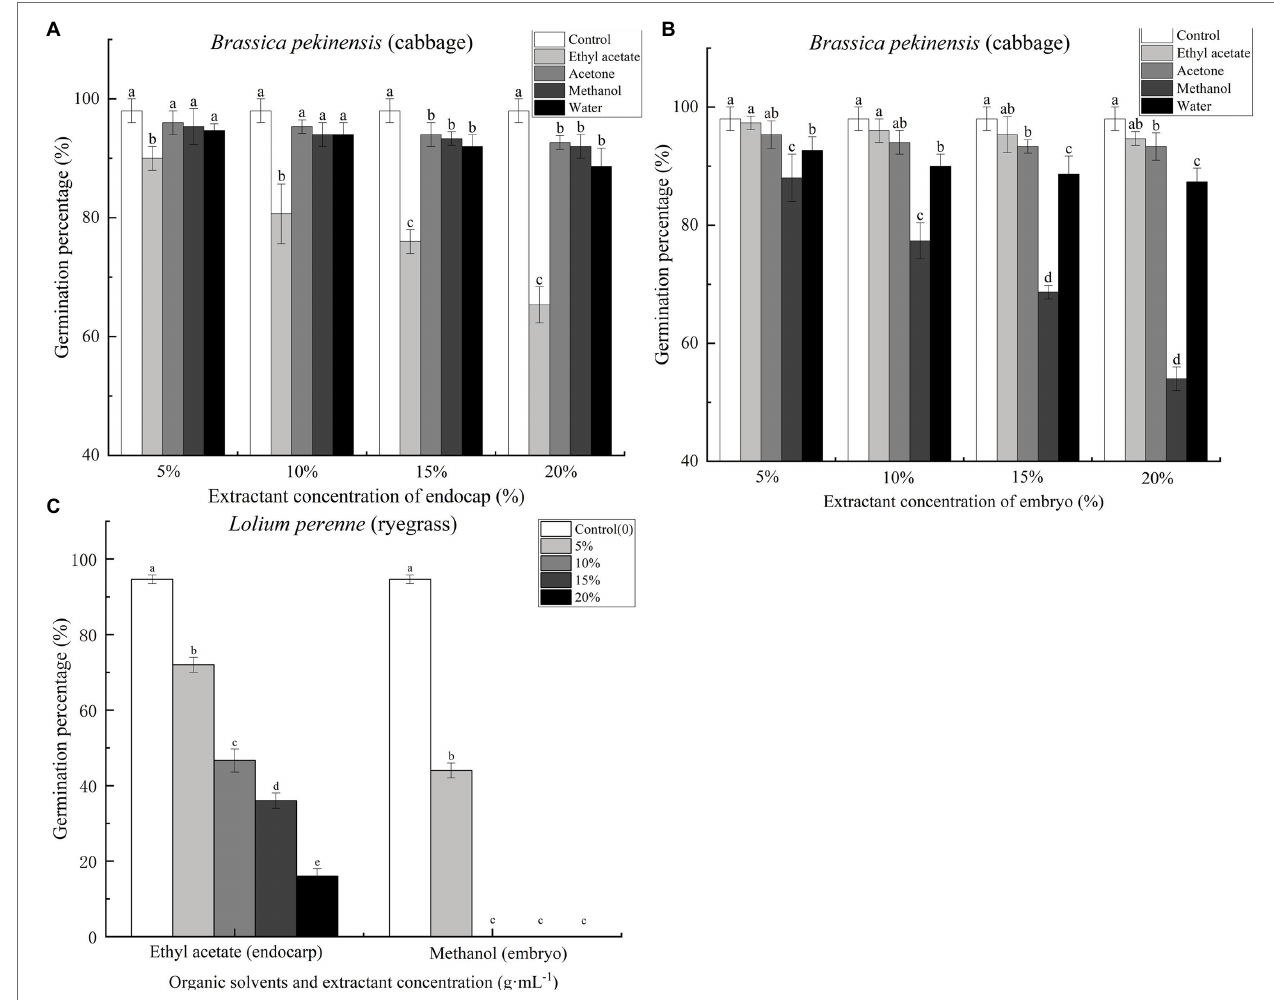
FIGURE 5 | Inhibitory effects of different extracts of Cinnamomum migao seeds on the germination of cabbage and ryegrass seeds. (A) Endocarp extracts and (B) Embryo extracts. (C) Effect of endocarp and embryo extracts on ryegrass seed germination. The x -axis denotes the concentration of the extracts, and the y -axis denotes the germination rate. Data are presented as means ± standard deviations ( n = 3). The values marked with different letters indicate the significance levels among the various extract treatments at the same concentration ( p < 0.05). Three replicates of 50 seeds each were used for each